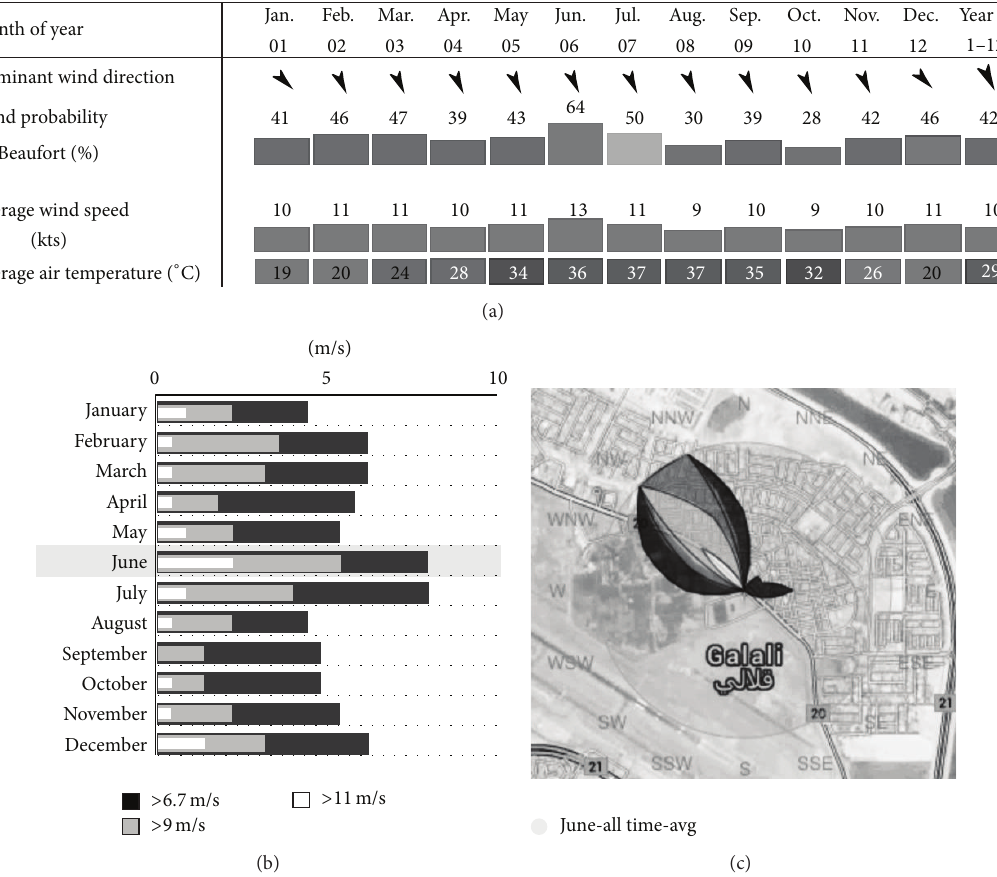
Figure 7: (a) Weather statistics based on observations taken between 2005 and 2014. (b) Wind days per month and (c) wind direction distribution in Bahrain